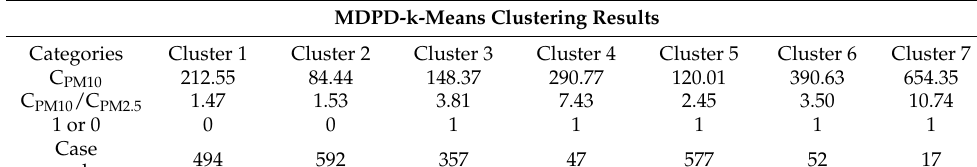
Table 2. Clustering centers of MDPD-k-means algorithm.